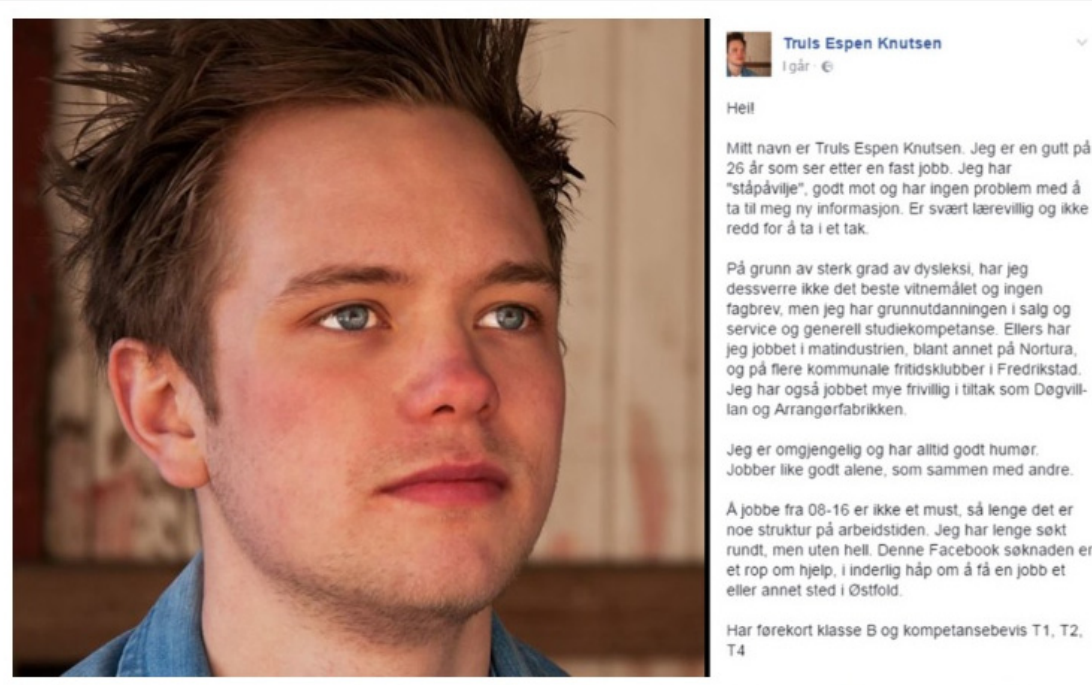
Figure 6. Job application on social media.